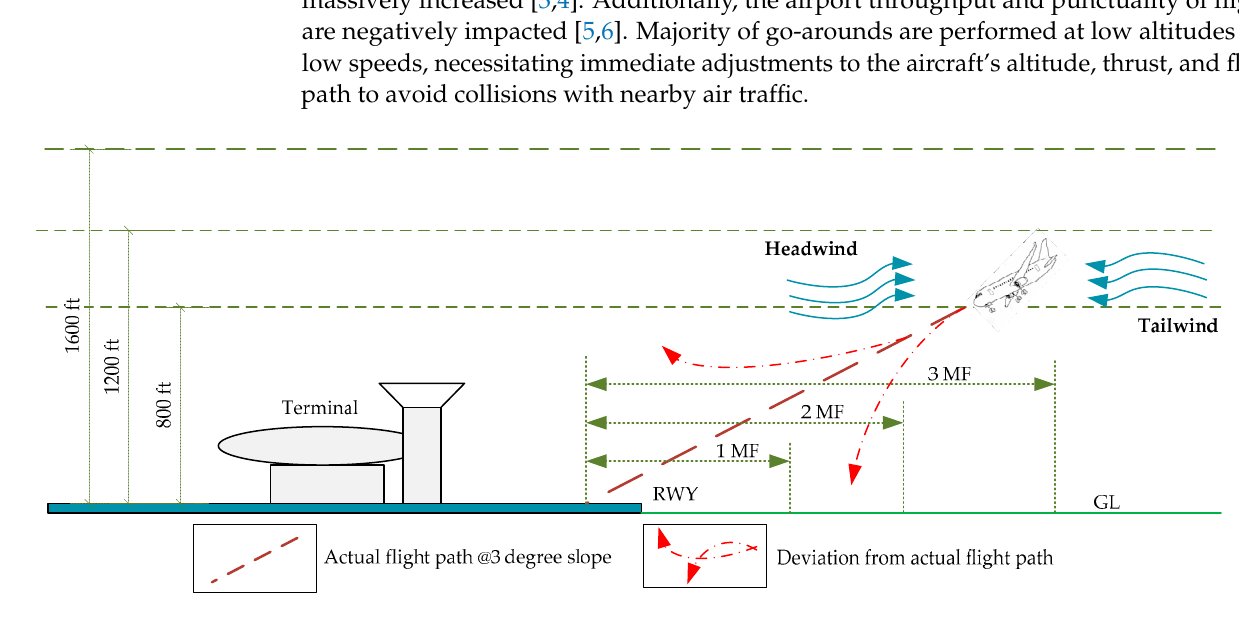
Figure 1. Occurrence location of WS events in the vicinity of the airport runway.